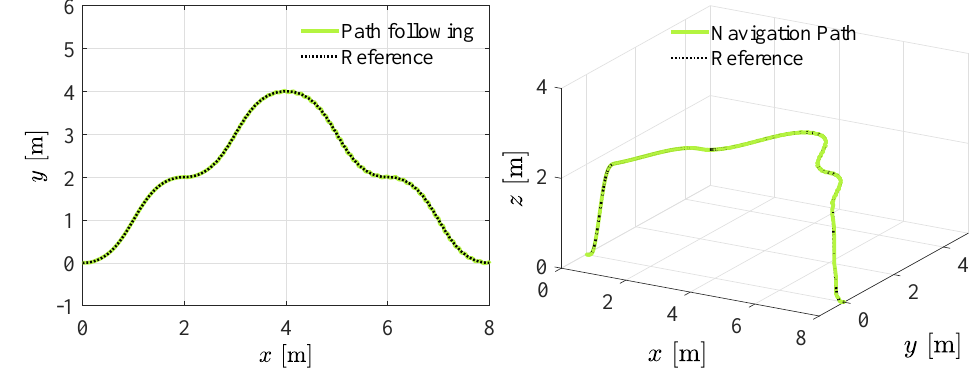
Figure 5. Quadrotor navigation on the plane and